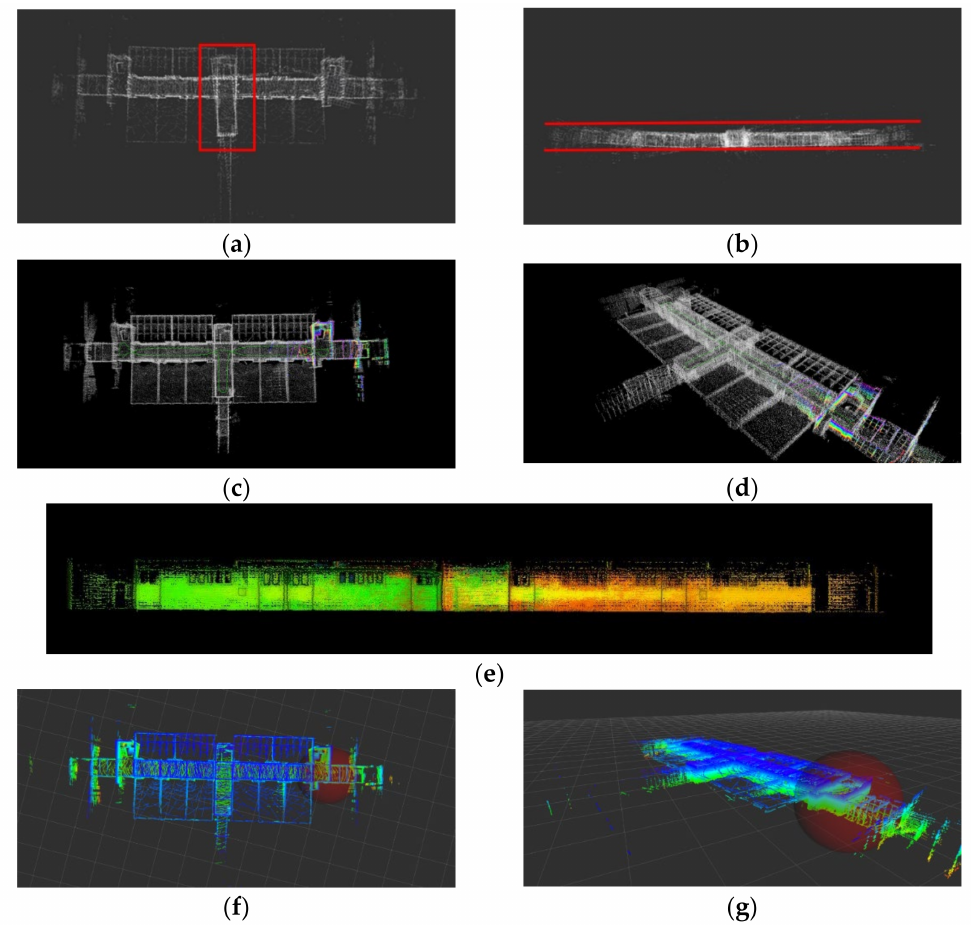
Figure 2. Results of the SLAM algorithms for long corridor environments: ( a ) top view of LOAM results; ( b ) side view of LOAM results; ( c ) top view of A-LOAM results; ( d ) perspective view of A-LOAM results; ( e ) side view of A-LOAM results; ( f ) top view of HDL Graph SLAM results; ( g ) perspective view of HDL Graph SLAM